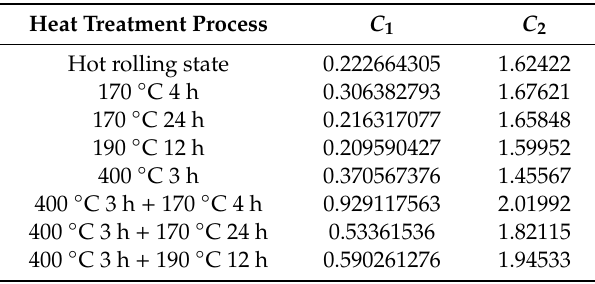
Figure 7. G–L curve of rolled ZK60 magnesium alloy. Table 3. Values of C 1 and C 2 .